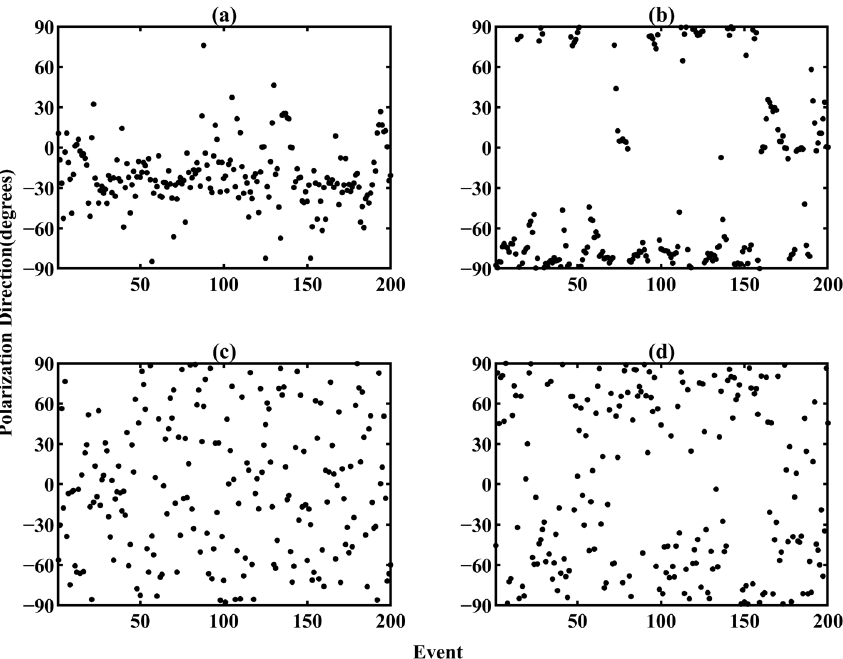
Figure 16. The polarization direction of the 5th test dataset. The electric field of ( a ) noise data and ( c ) denoising data at 0.2 Hz. The magnetic field of ( b ) noise data and ( d ) denoising data at 0.2 Hz. Dots denote the polarization direction of different data sections.